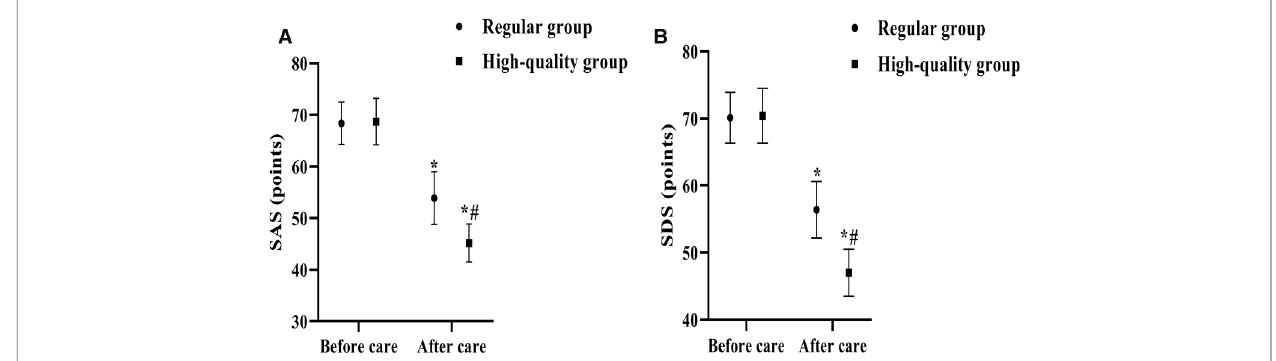
FIGURE 3 | Comparison of psychological status scores between the two groups before and after care. (Mean, SD), Note: ( A ) shows SAS scores, ( B ) shows SDS scores. * shows the difference with the same group before care, p <0.05; # shows the difference with the Regular group,